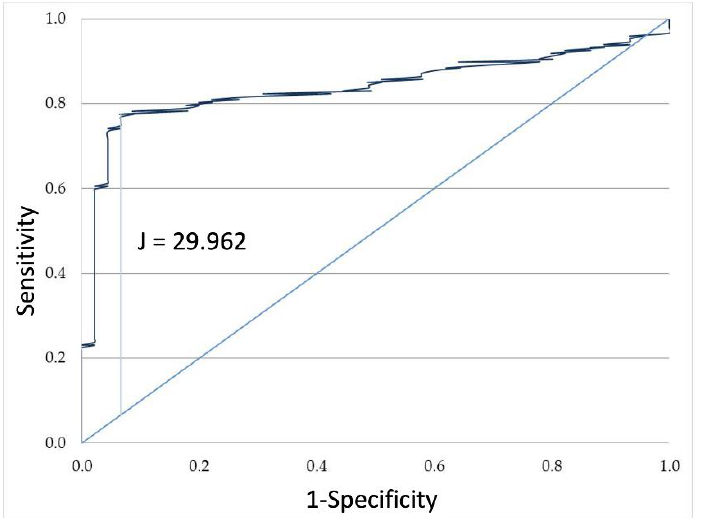
Figure 2. ROC curve of semen F 2 -IsoP levels in fertile (n. 45) and infertile (n. 147) subjects considered in this study.